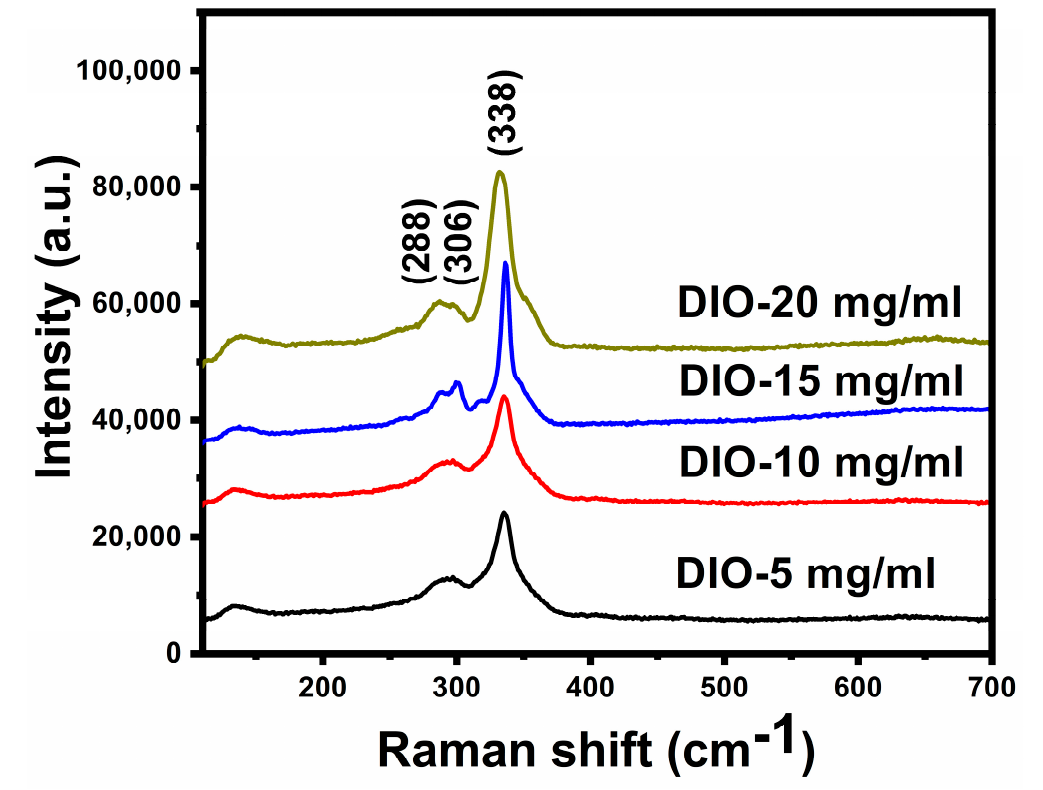
Figure 3. Raman spectra of Cu 2 ZnSnS 4 (CZTS) absorber films in the wavenumber region of 100–700 cm − 1 , were prepared using different 1,8-diiodooctane (DIO) additive concentrations.